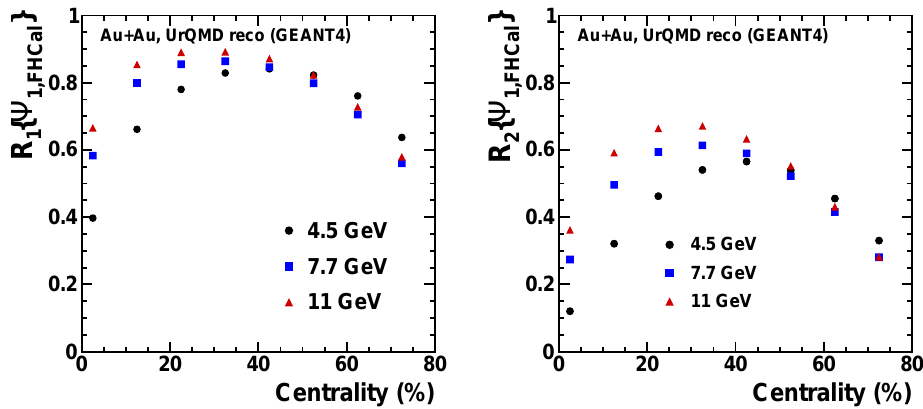
Figure 6. Centrality dependence of event plane resolution factors R n ( Ψ 1,FHCal ) for the directed v 1 ( left ) and elliptic v 2 ( right ) flow measurements for Au + Au collisions at the Au + Au (open symbols) and Bi + Bi (filled symbols) collisions at As expected they have very similar values for the same bins in the collision